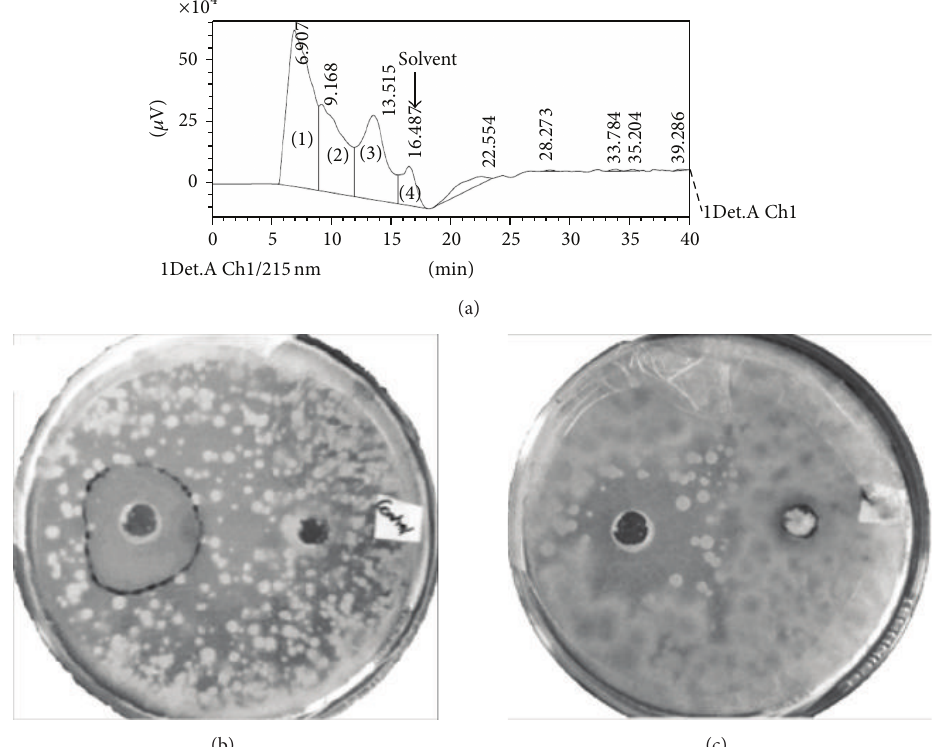
Figure 5: (a) HPLC analysis. Peak 1 was selected for analysis based on (b) antifungal activity of peak 1 at 3 days after incubation and (c) antifungal activity of peak 1 at 7 days after incubation.